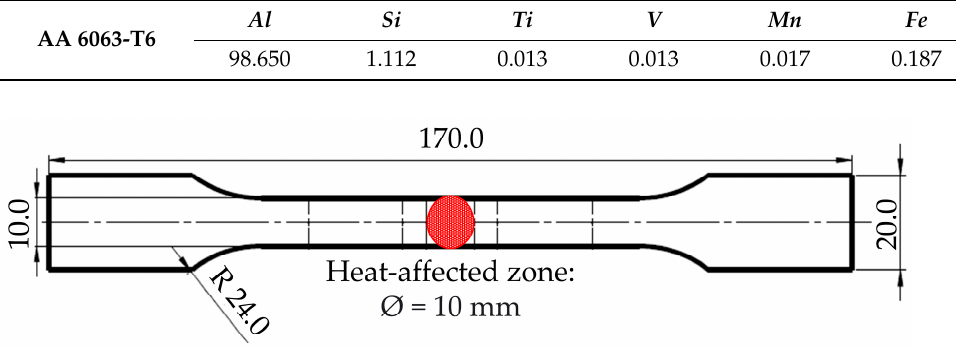
Figure 2. Heat-affected design and laser focus area.